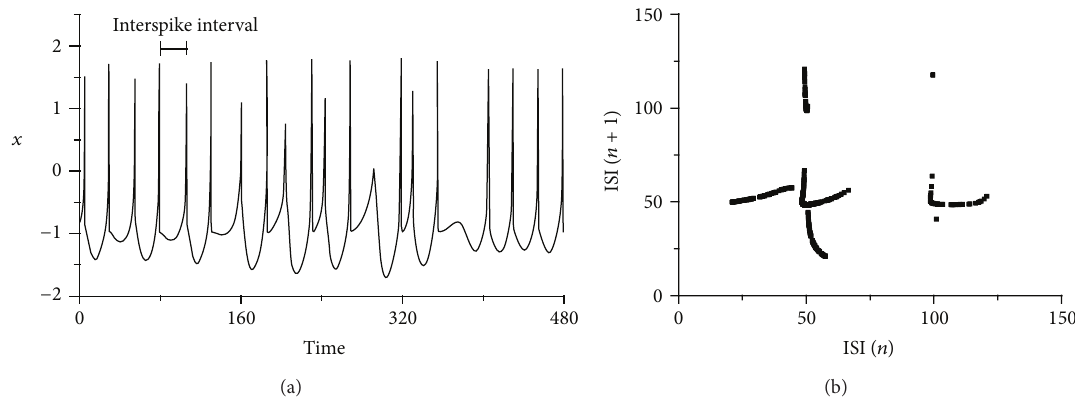
Figure 3: Chaotic firing pattern between period-1 bursting and period-2 bursting simulated in the HR model with 𝑟 = 0.0245 and 𝐼 = 2.53 . (a) Spike trains. (b) The first return map of the ISI